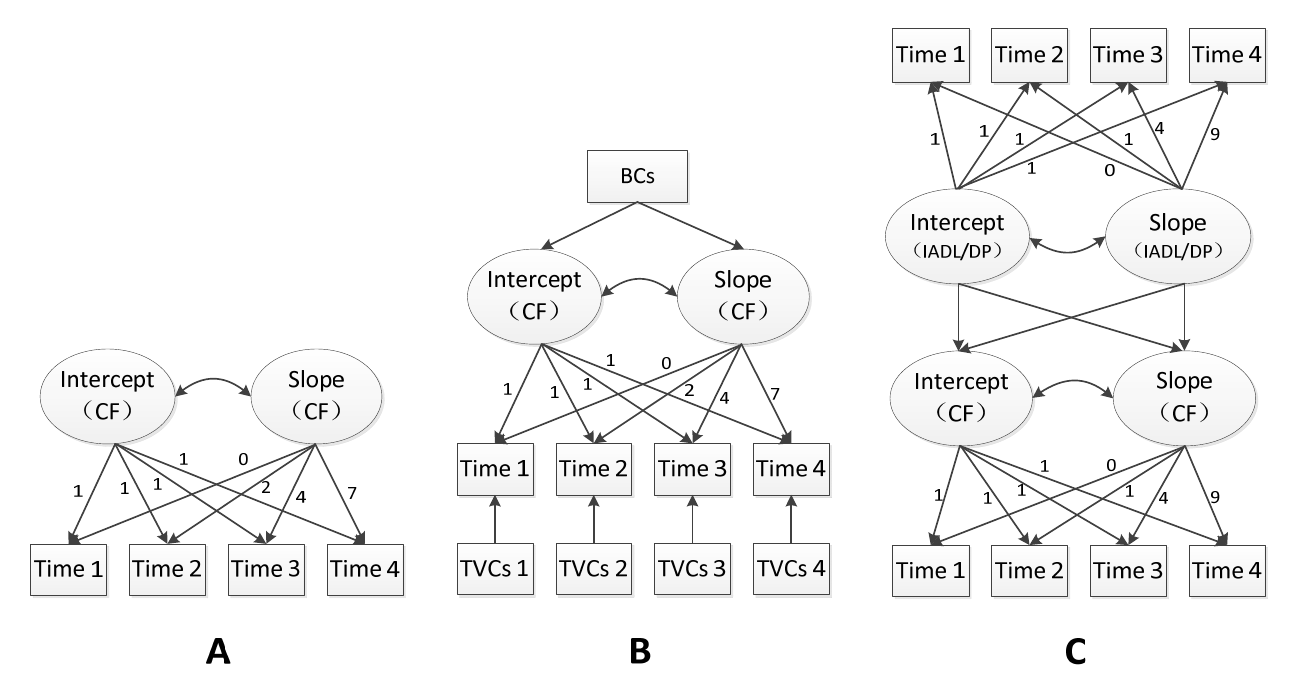
Figure 2. Hypothesized latent growth curve model (LGCM) of this study. CF: Cognitive Function, including Global Cognition and 5 dimensions (Orientation, Episodic Memory, Calculation, Constructability); BCs: Baseline Covariates, including age, gender, education, marriage, napping time, night sleeping time, the number of cardiovascular and cerebrovascular diseases, drinking, smoking, instrumental activities of daily living (IADL), and depression (DP); TVCs: Time-Varying Covariates, including marriage, napping time, night sleeping time, the number of chronic diseases, IADL, and depression (DP) across 4 waves. Model ( A ): Univariate LGCM, to investigate the trajectories of CF across 4 waves. Model ( B ): Conditional LGCM, to investigate the trajectories of CF and its association with BCs and TVCs. Model ( C ): Unconditional Parallel Process LGCM (PP-LGCM), to investigate the relationship between CF, IADL, and DP across 4 waves. (The data were collected at 2011, 2013, 2015, and 2018, which accounted for the time coefficients of 0, 2, 4, and 7 in model ( A ) and model ( B ). Since the trends of IADL and depression showed curvilinear changes, the quadratic curve growth patterns were explored with time coefficients of 0, 1, 4, and 9 in model ( C )).